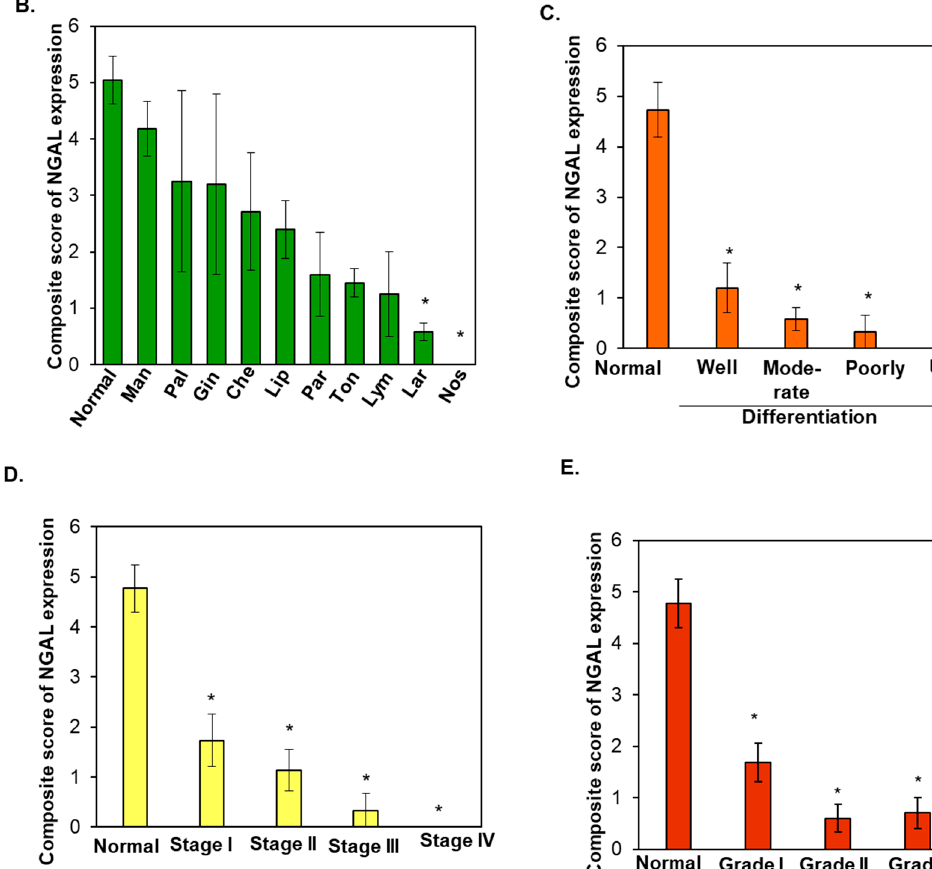
Figure 1. Expression of NGAL (neutrophil gelatinase-associated lipocalin) in oral cancer. ( A ) Representative images of expression of NGAL in oral cancer (left panel). Expression of NGAL in normal (no. of samples ( n ) = 21) vs. malignant ( n = 139) oral cancer tissues (right panel). ( B ) Expression of NGAL in different tissues of oral cancer. Lar: Larynx, Nos: Nose, Ton: Tongue, Che: Cheek, Gin: Gingiva, Lym: Lymph node, Man: Mandible, Par: Parotid gland, Pal: Palate. ( C ) Expression of NGAL with degree of differentiation of oral cancer. ( D ) Expression of NGAL in different stages of oral tongue cancer tissues. ( E ) Expression of NGAL in different grades of oral tongue cancer tissues. Data are mean ± SE. * = p < 0.05.